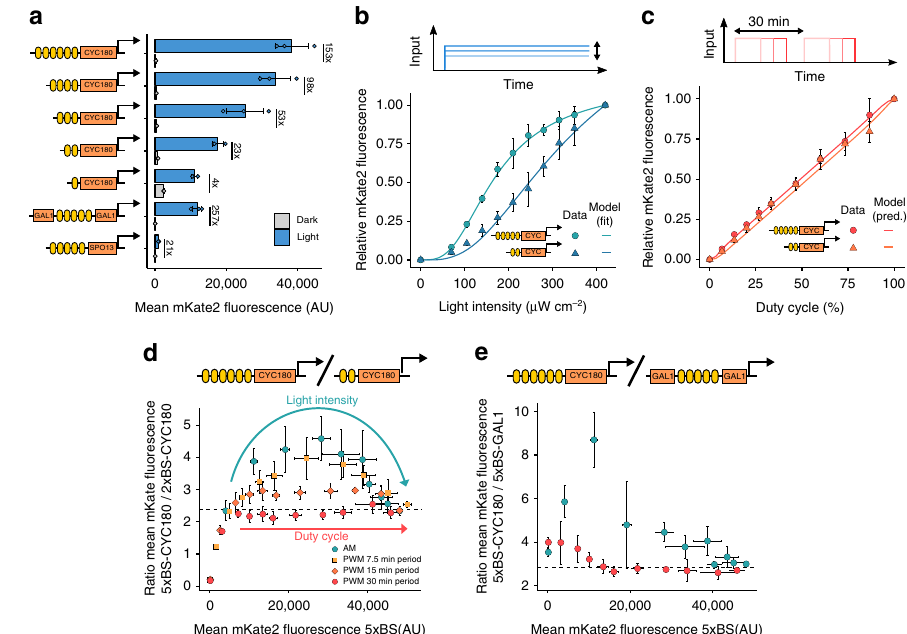
Fig. 2 Coordinated multi-gene regulation using dynamic inputs. a A promoter library for gene expression at various expression levels. Schematics represent the different promoters. Yellow boxes represent EL222 binding sites and orange boxes represent partial sequences of yeast promoters. Strains, expressing mKate2 under the control of the respective promoter, were cultured for 6 h in the dark or the presence of blue light (350 µ W cm − 2 ). The average cellular mKate2 fl uorescence was measured using fl ow cytometry. Data represent the mean and s.d. of three independent experiments. b and c Dose-response of two promoters to AM ( b ) and PWM ( c ). Strains expressing mKate2 under the control of either a CYC180 promoter with fi ve (circle, 5xBS) or two (triangle, 2xBS) VP-EL222 binding sites were grown under the illumination conditions depicted on the x -axis for 6 h. The light intensity and period for PWM were 420 µ W cm − 2 and 30 min. Mean cellular fl uorescence measurements were normalized to be 0 in the dark and 1 at the highest input level to allow for easy comparison. Non-normalized values are shown in Supplementary Fig. 7. Data represent the mean and s.d. of three independent experiments. Lines represent model fi ts or predictions. d Relative gene expression levels for different induction condition. Strains (as in b and c ) were grown under the same illumination conditions (light intensity and duty cycle) as shown in b and c . In addition, the effect of the PWM period on coordinated expression was explored. The ratio of mKate2 expression from the 5xBS and the 2xBS promoter is plotted against the mKate2 expression from the 5xBS promoter for the same illumination conditions. The dashed line represents this ratio at constant illumination with a light intensity of 420 µ W cm − 2 . Data represent the mean and s.d. of three independent experiments. e Relative gene expression levels between a CYC180 and GAL1 based promoter with fi ve binding sites for different induction condition. Experiments were performed as described in ( d ). Data represent the mean and s.d. of three independent experiments for the